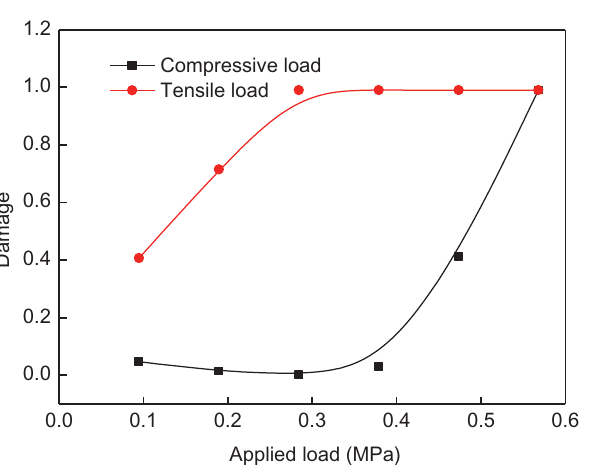
Figure 11: Effect of the applied load on the damage at compressive and tensile loads.